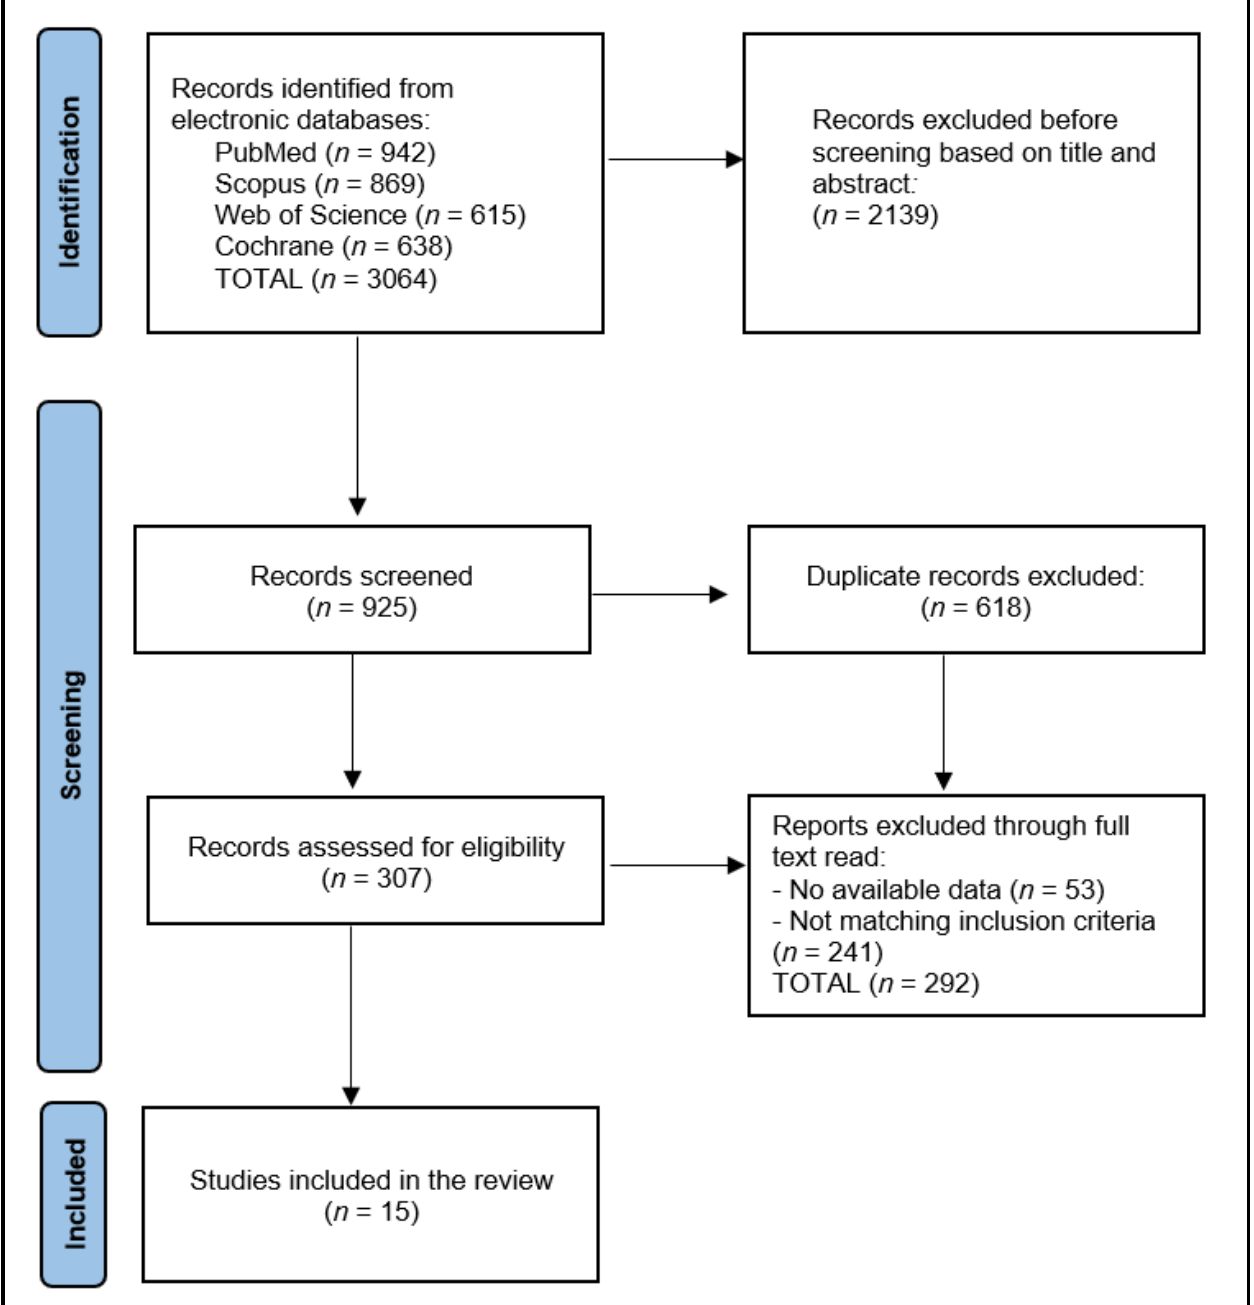
Figure 1. PRISMA flow diagram.